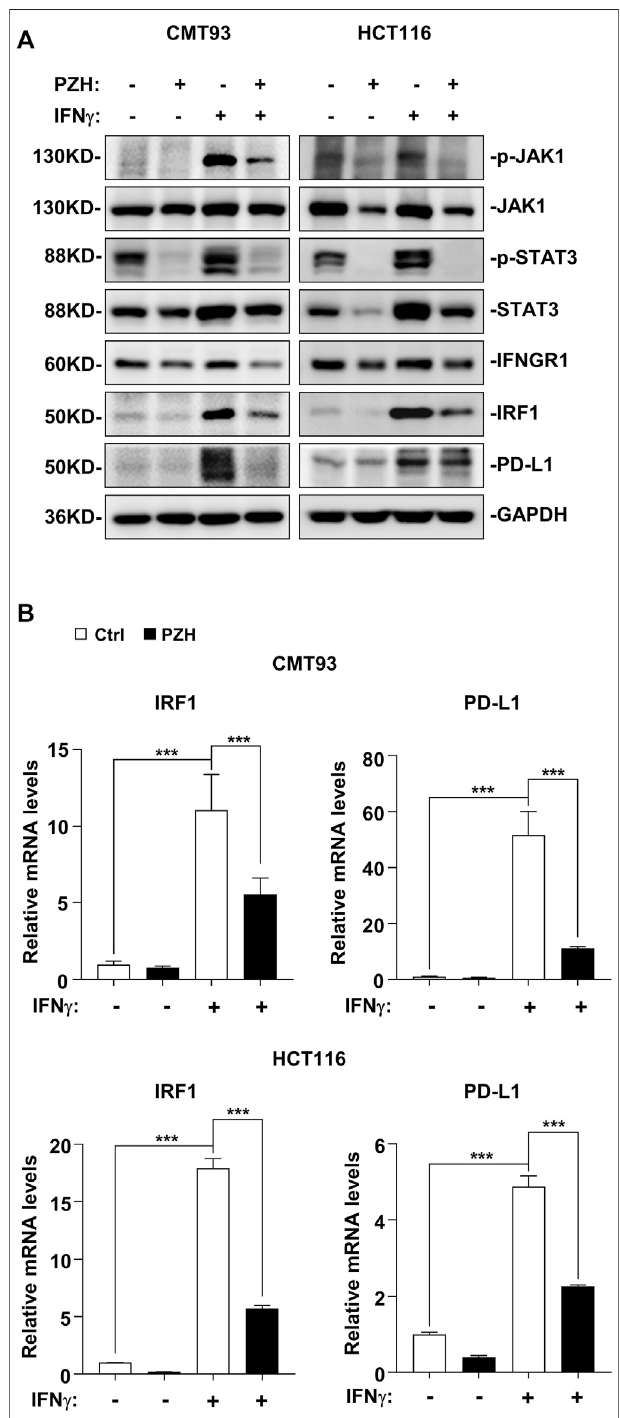
FIGURE 5 | PZH suppressed IFN γ stimulation signal and PD-L1 up- regulation via inhibiting the IFNGR1-JAK1-STAT3-IRF1 signaling. (A) IFN γ - inducedp-JAK1, p-STAT3,IRF1, andPD-L1 protein levelswereattenuatedin PZH treated CMT93 and HCT116 cells, as well as the basal IFNGR1 protein level. (B) The mRNA levels of IRF1 and PD-L1 induced by IFN γ were decreased in PZH treated CMT93 and HCT116 cells ( n = 3 – 4 per group). The results are representative of one of three experiments. Data are presented as means ± SD, *** p < 0.001 based on one-way ANOVA.